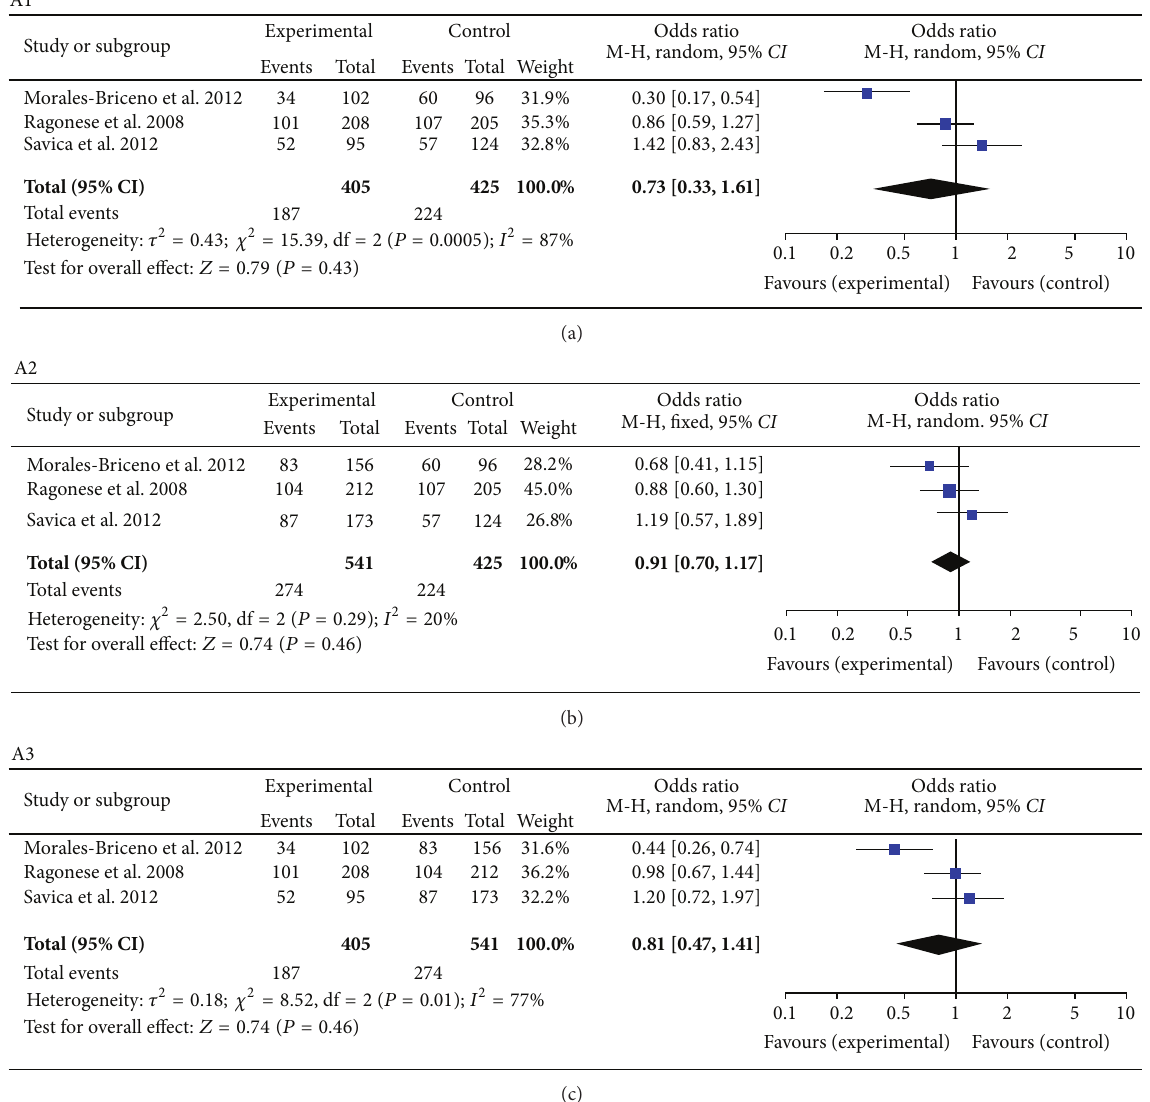
Figure 2: Forest plots for case-control study with all included studies. Meta-analysis of studies reporting BMI and PD versus controls, 95% confidence